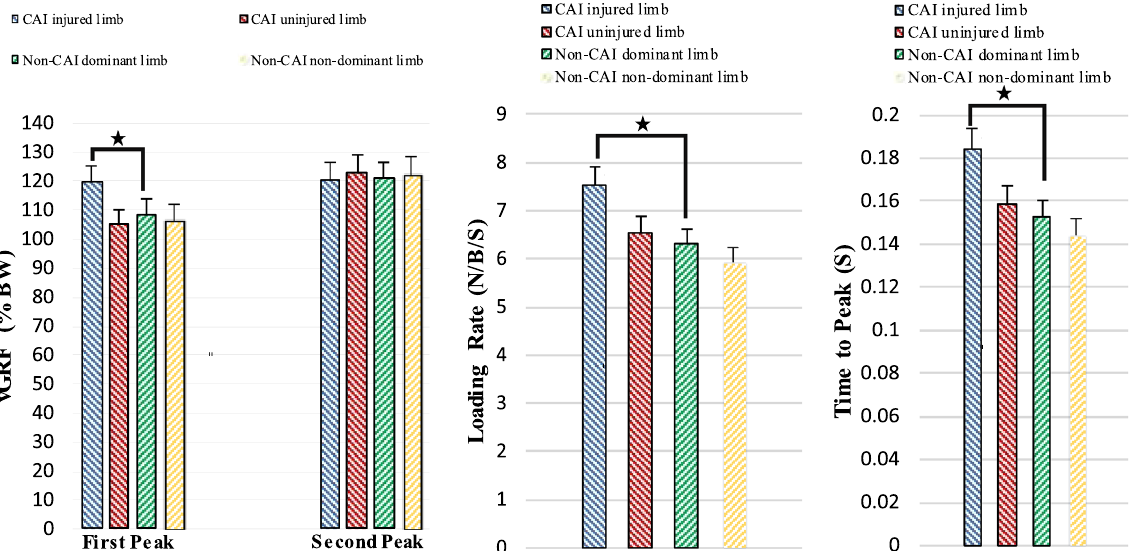
Figure 1. Average and standard division of vGRF, loading rate and time to peak in CAI and Non-CAI groups during walking. CAI Chronic ankle instability, vGRF Vertical ground reaction force. *Significant different between the